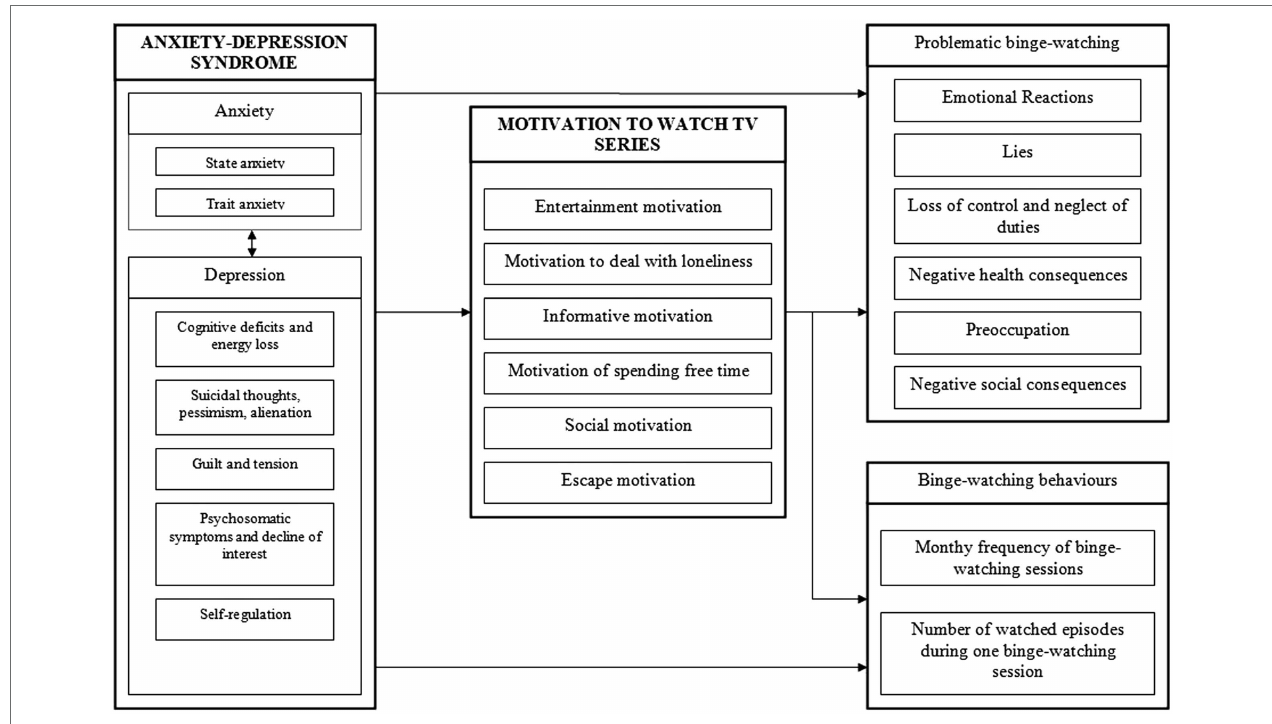
FIGURE 1 | Theoretical